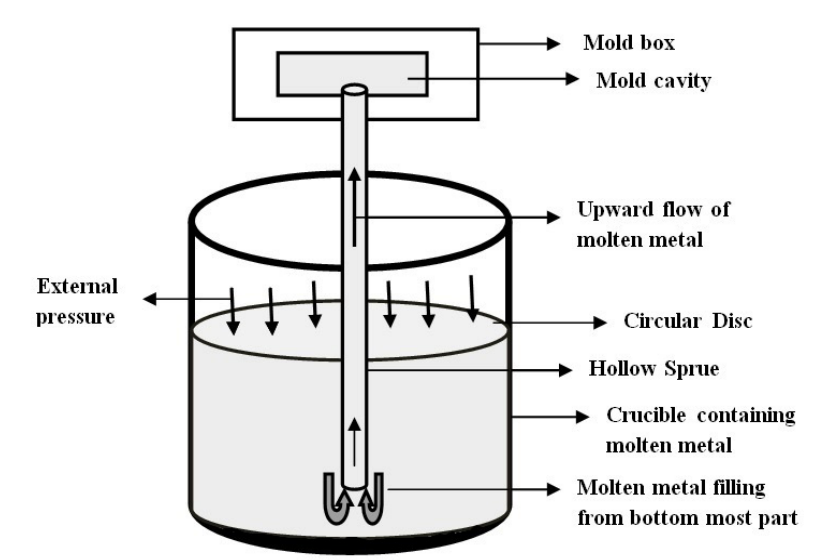
Figure 1. Schematic view of the